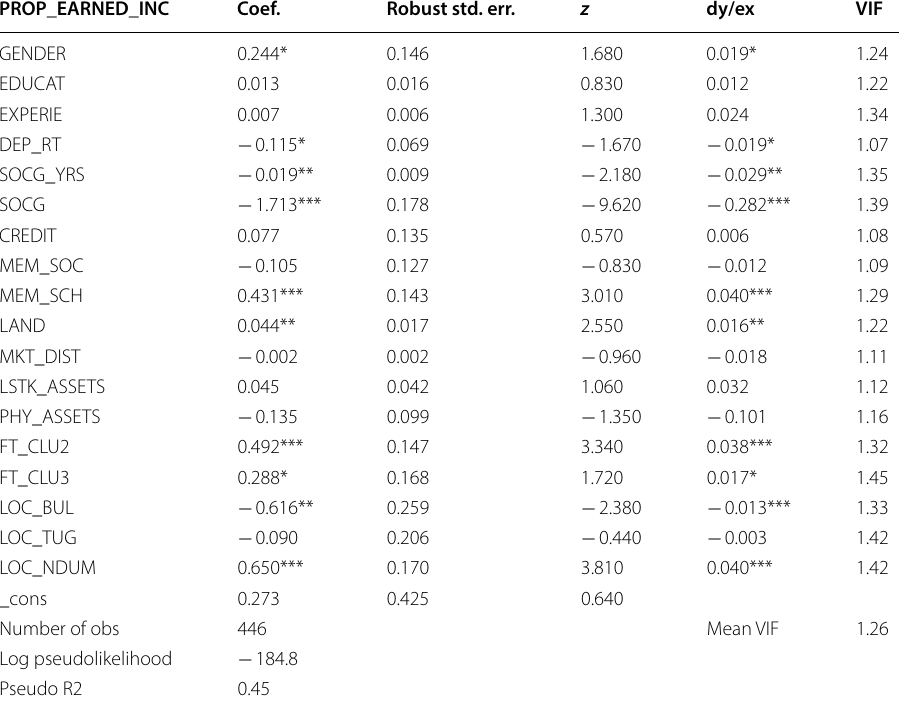
Table 5 Fractional regression model